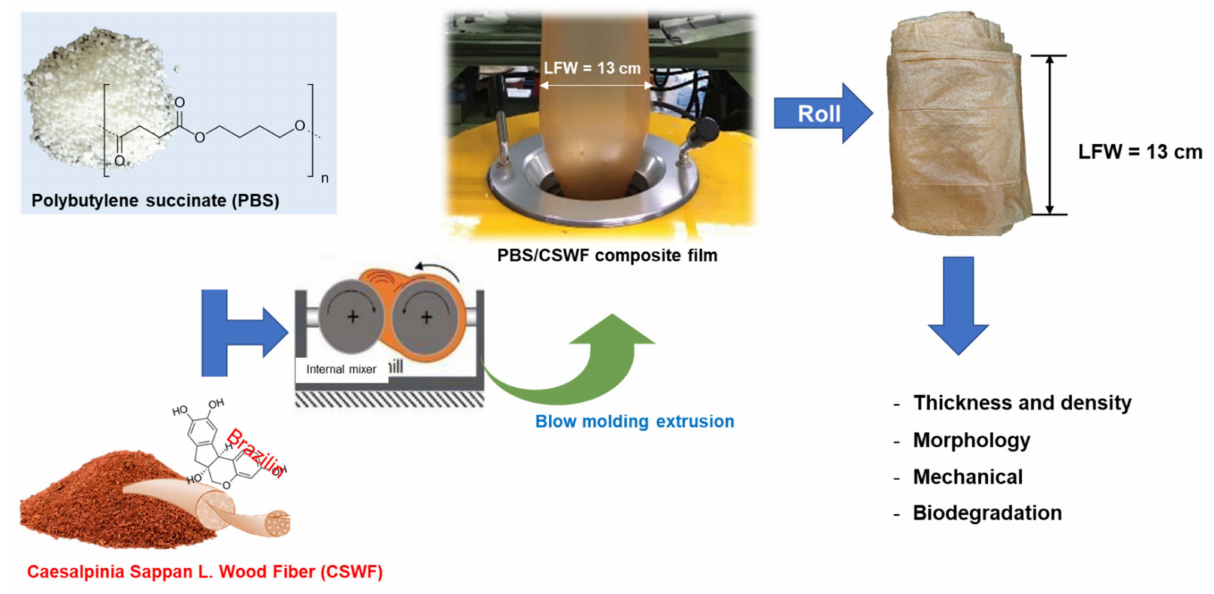
Figure 1. A short overview of PBS/CSWF composite preparation